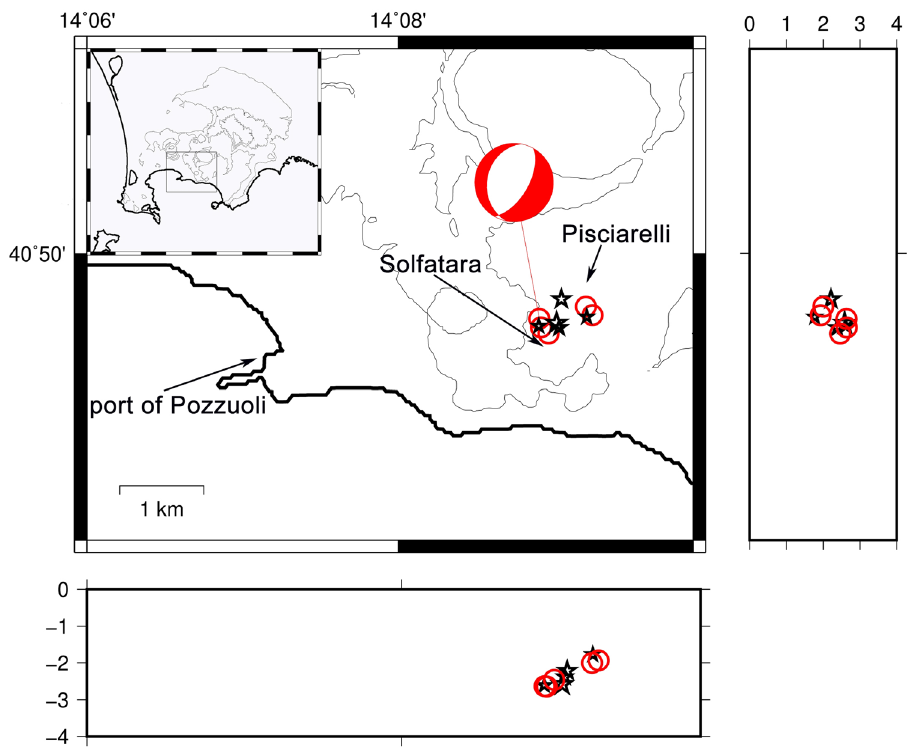
Figure 2. Location of the earthquakes of the swarm of 22/08/2000 obtained using the NLLoc program with a 3D velocity model 27 (grey circles) and the HypoDD program in a 1D velocity model (black stars). Beach ball shows the focal mechanism of the Md = 2.1 earthquake. The figure was obtained using the free software GMT 5.3.1 (https:// www. gener ic- mappi ng- tools.